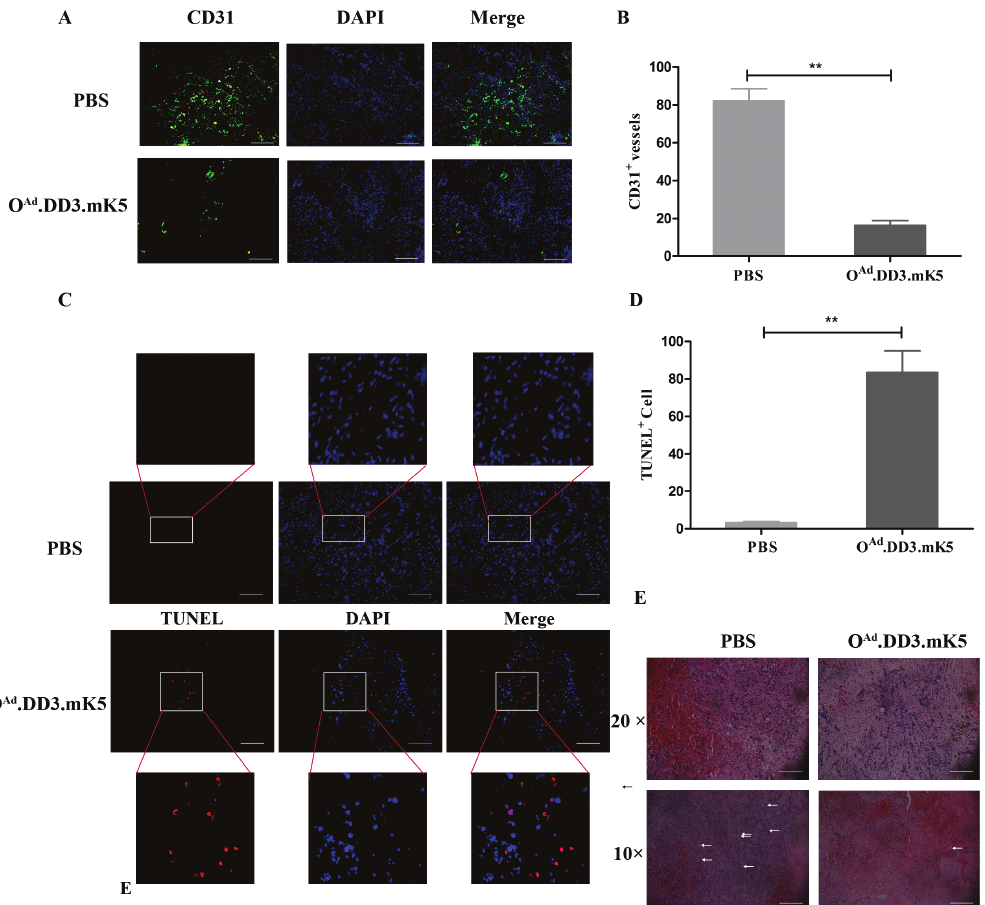
Figure 6: Anti-angiogenic and anti-cell proliferation effects of O Ad .DD3.mK5 in LNCaP mouse model. A.CD31 immunofluorescence stai- ning of tumors tissue isolated from mice after O Ad .DD3.mK5 or PBS treatment. B. Quantification on the positive CD31+ vessels number (n=3). C. Representative images of TUNEL staining from tumor tissue after O Ad .DD3.mK5 or PBS treatment. D. Quantification of the TUNEL staining(n=3). E. H&E staining of the tumors tissue. Arrows indicate the vessels in tumor tissue. Scale bar, 200 μm. All experiments date were repeated three times, and the bars represent the mean ± S.D. (n = 3).